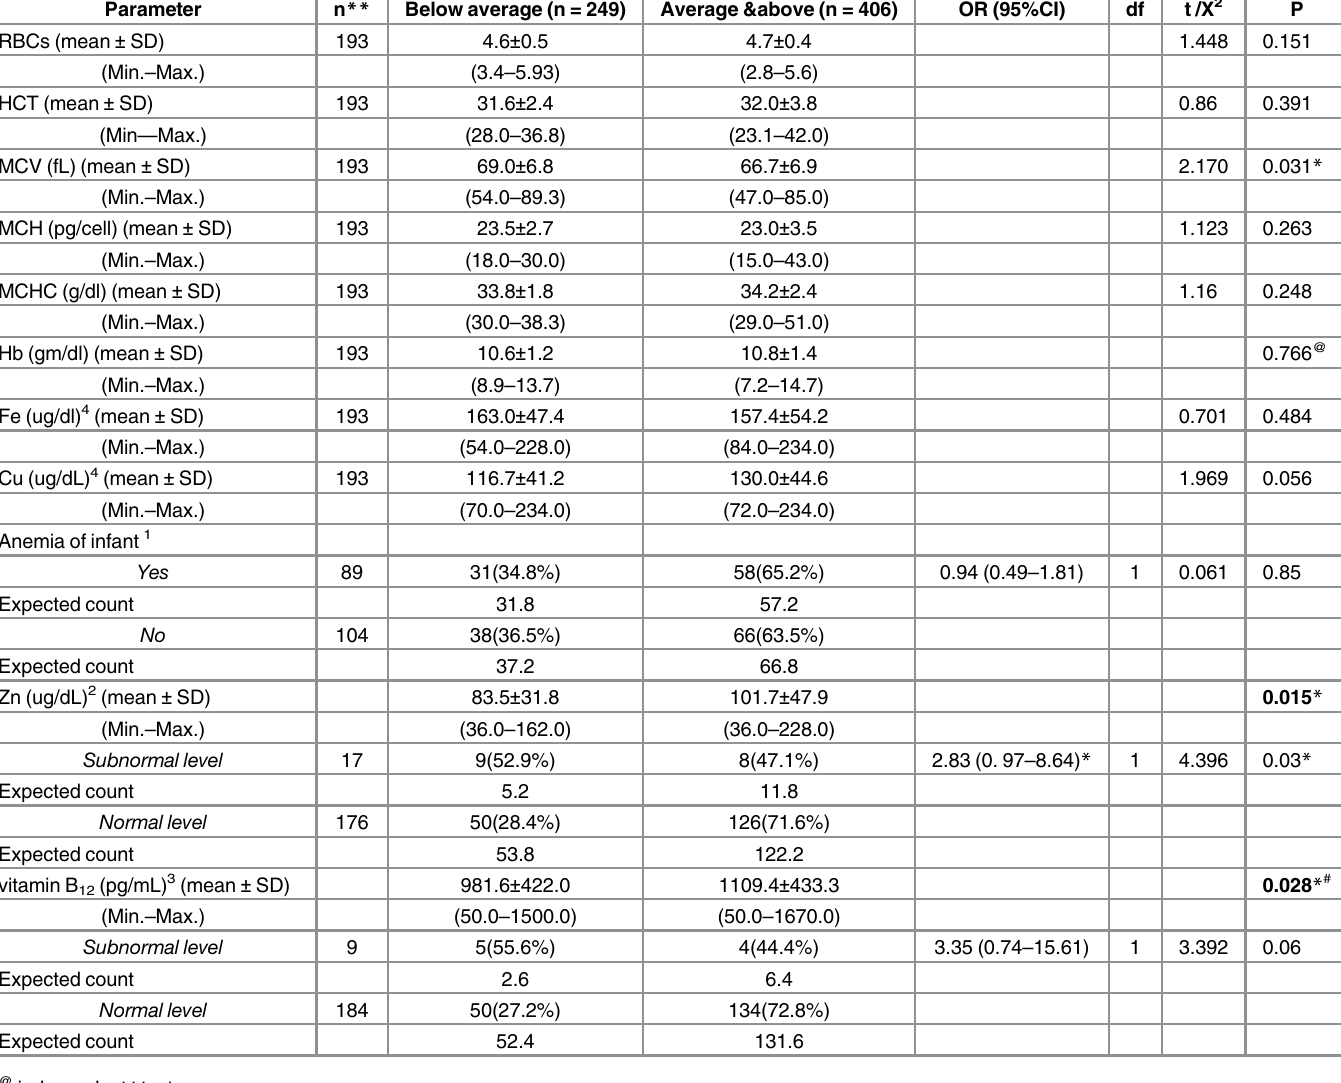
Table 3. Association of the level of infant biochemical parameters with socio-emotional composite scores categories in a group of 655 Egyptian infants and children aged 6 – 24 months old.